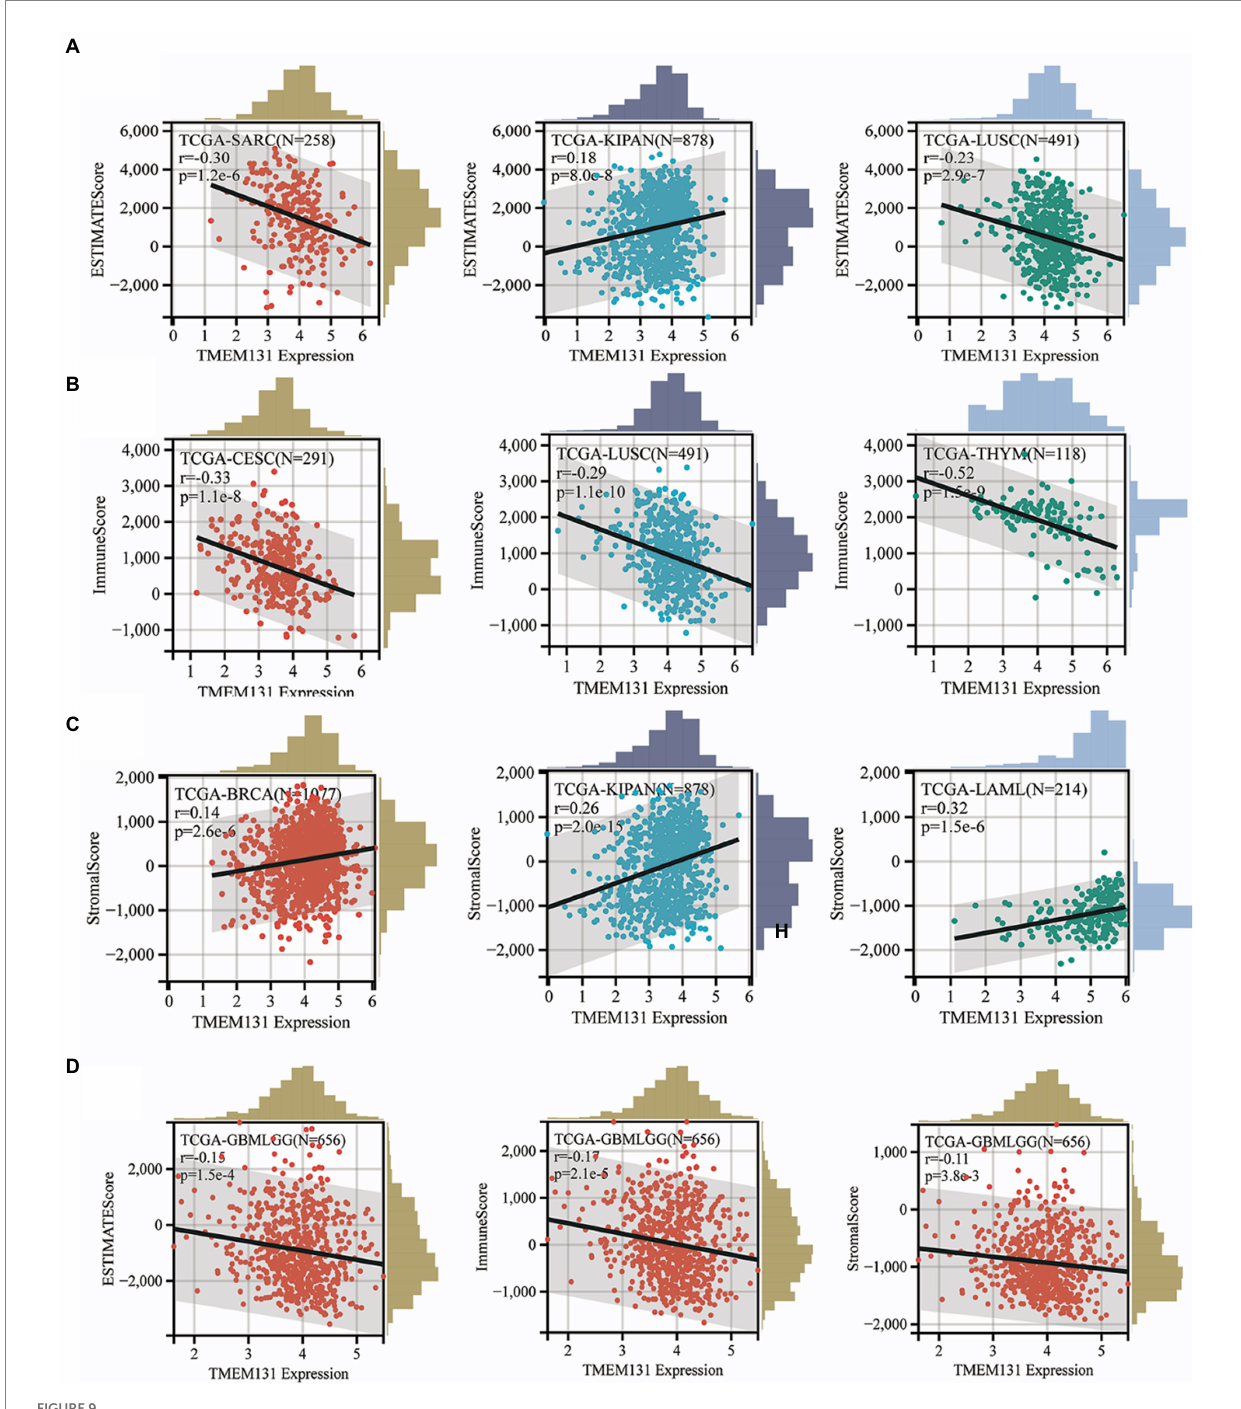
FIGURE 9 Stromal, immune, and ESTIMATE scores of each tumor patient were calculated according to the expression of TMEM131L. (A–C) Top3 scatter plots with the most significant correlation; (D) Scatter plots of correlation between TMEM131L and stromal, immunity, and estimation in GBM and LGG,